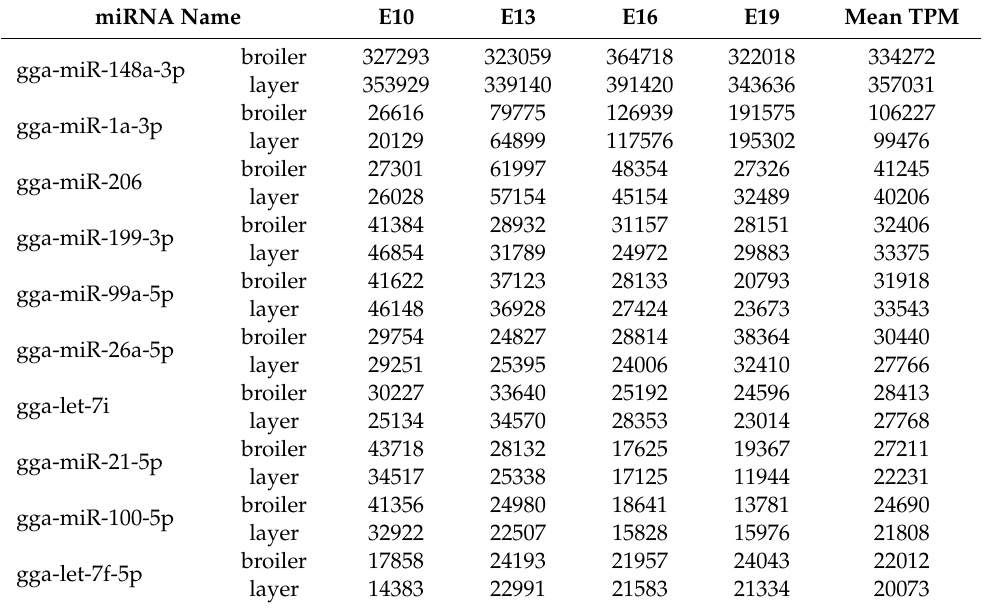
Figure 1. Characterization of known and predicted novel microRNAs (miRNAs) in chicken breast muscle. ( a ) Length distribution and abundance of miRNAs sequences, clean reads of 18–27 nt for all four groups were assessed, and the most abundant size class was 22 nt; ( b ) distribution of miRNAs with 0 to > 10,000 mean transcripts per million (TPM). Table 1. Top 10 most abundant known miRNAs in chicken skeletal muscle.